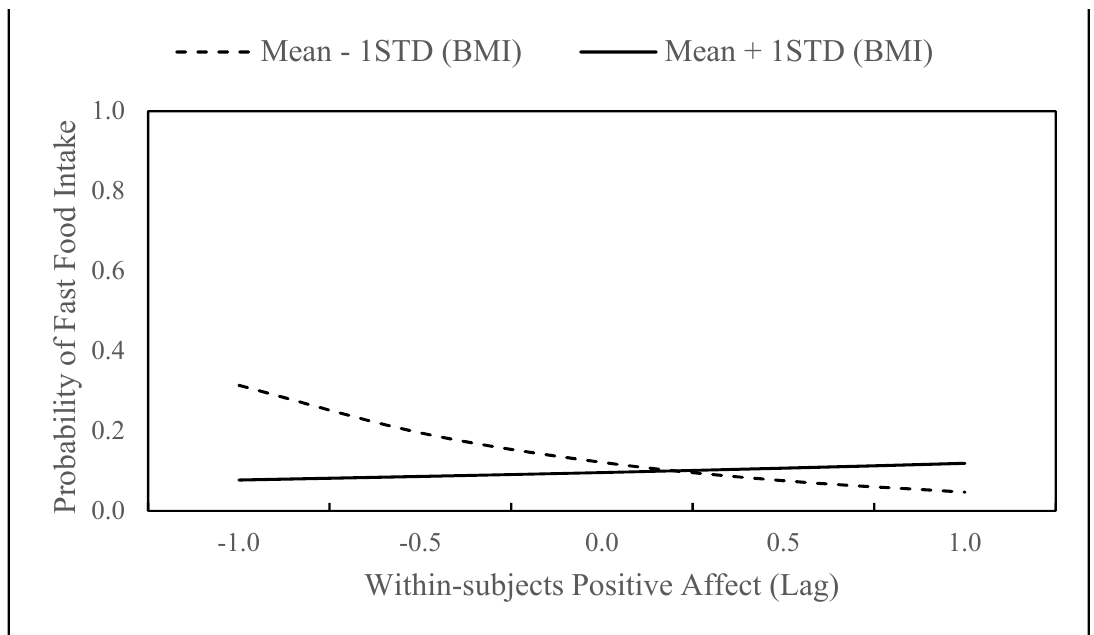
Figure 4. Two-way interaction of lagged within-subjects positive affect and pre-pregnancy BMI predicting fast food intake. The x-axis shows values of within-subjects positive affect with 0 representing one’s own average level of positive affect, positive values representing greater than one’s own average level of positive affect, and negative values representing lower than one’s own average level of positive affect. The y-axis represents the probability of fast food intake.